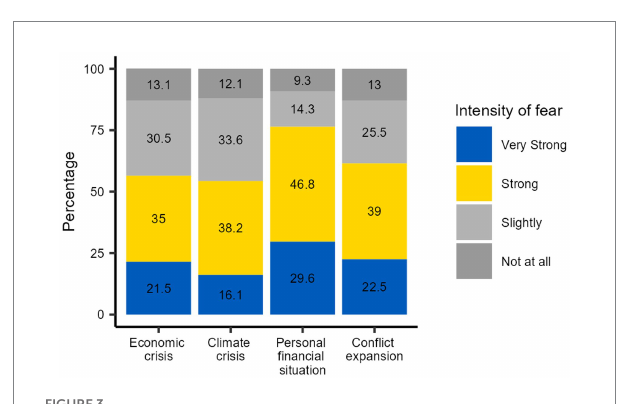
FIGURE 3 Specific fears related to war 6 month after the start of the war